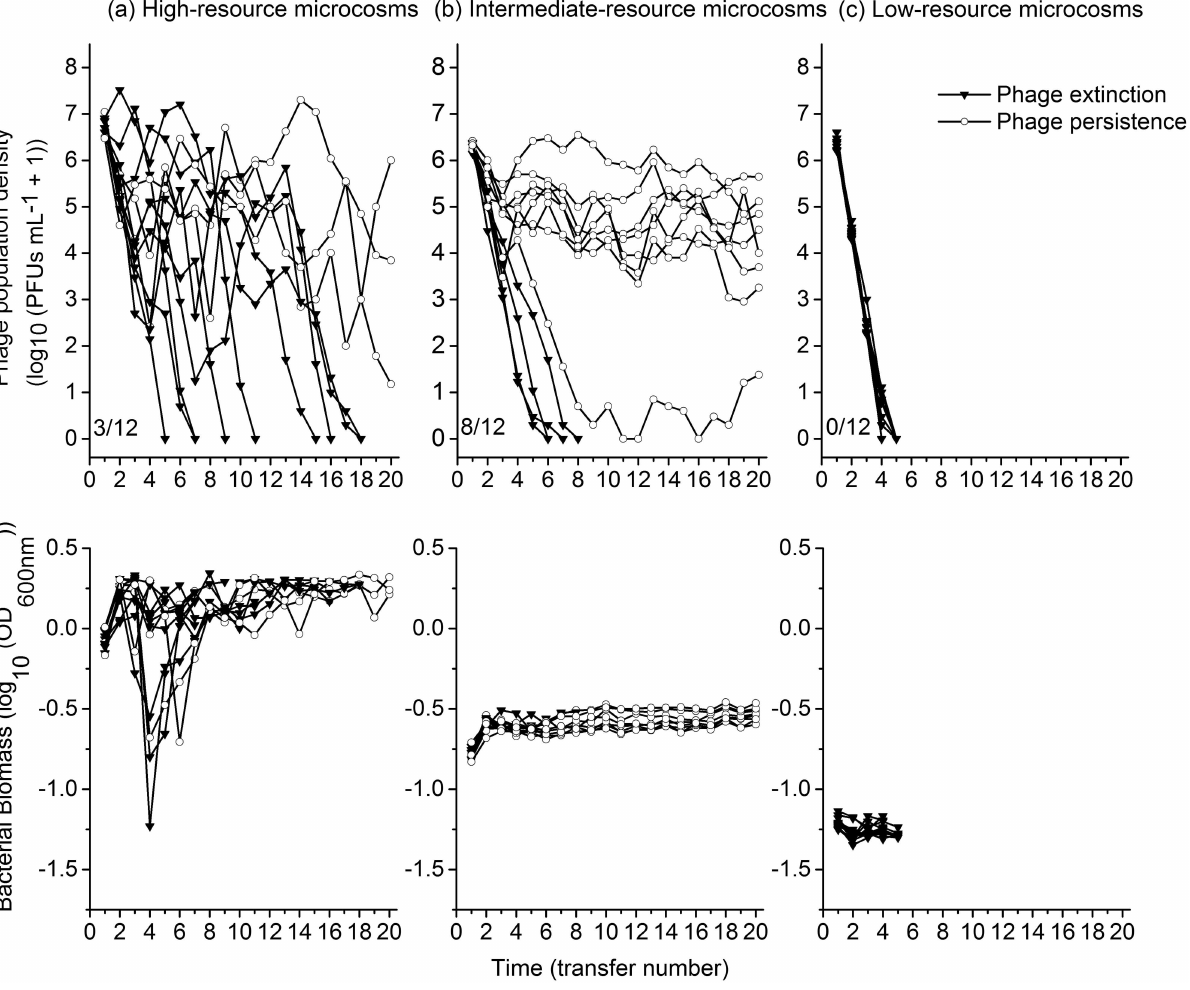
Fig 1. Phage and bacterial densities in microcosmsthrough time. Phage and bacterial densitiesover time in microcosms of high- (column a), intermediate- (columnb) and low-resource microcosms (column c). Each line indicatesan individualphage or bacterial line. The numbers in panelsof the first row indicatethe frequenciesof phage populationsthat persisteduntil the end of the